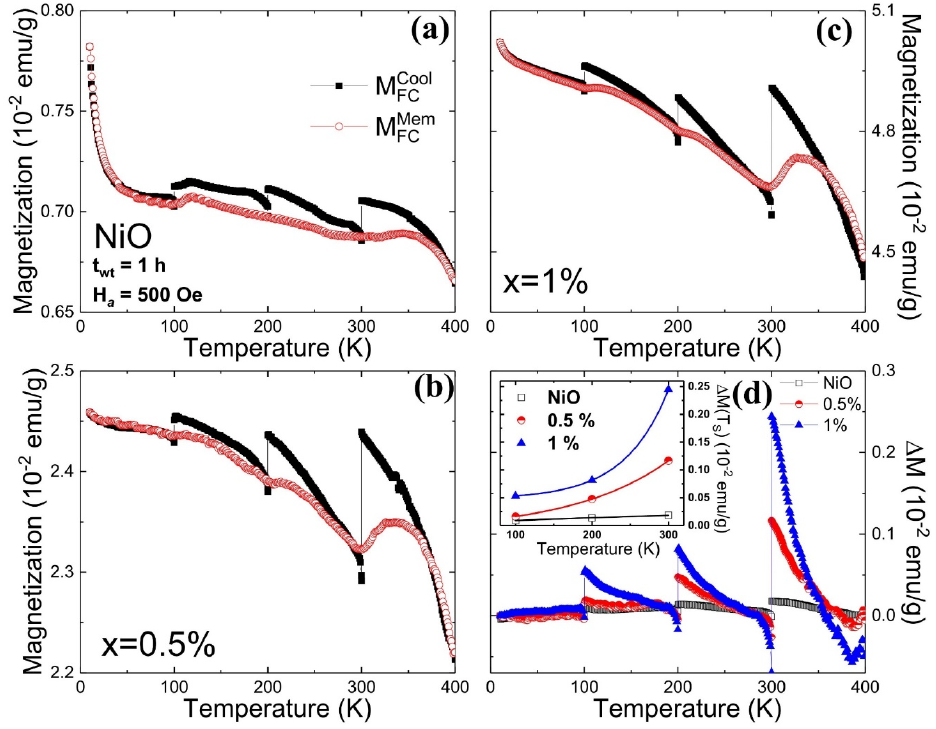
Figure 6. The FC magnetic memory e ff ect from ( a ) NiO, ( b ) 0.5%, and ( c ) 1% samples. ( d ) The di ff erence in magnetization ∆ M = M cool − M (cid:2890)(cid:2887)(cid:2923)(cid:2915)(cid:2923) concerning temperature. The value of maximum ∆M(T (cid:2903) ) at each stopping temperature, T S is given in the inset of a figure ( d ).